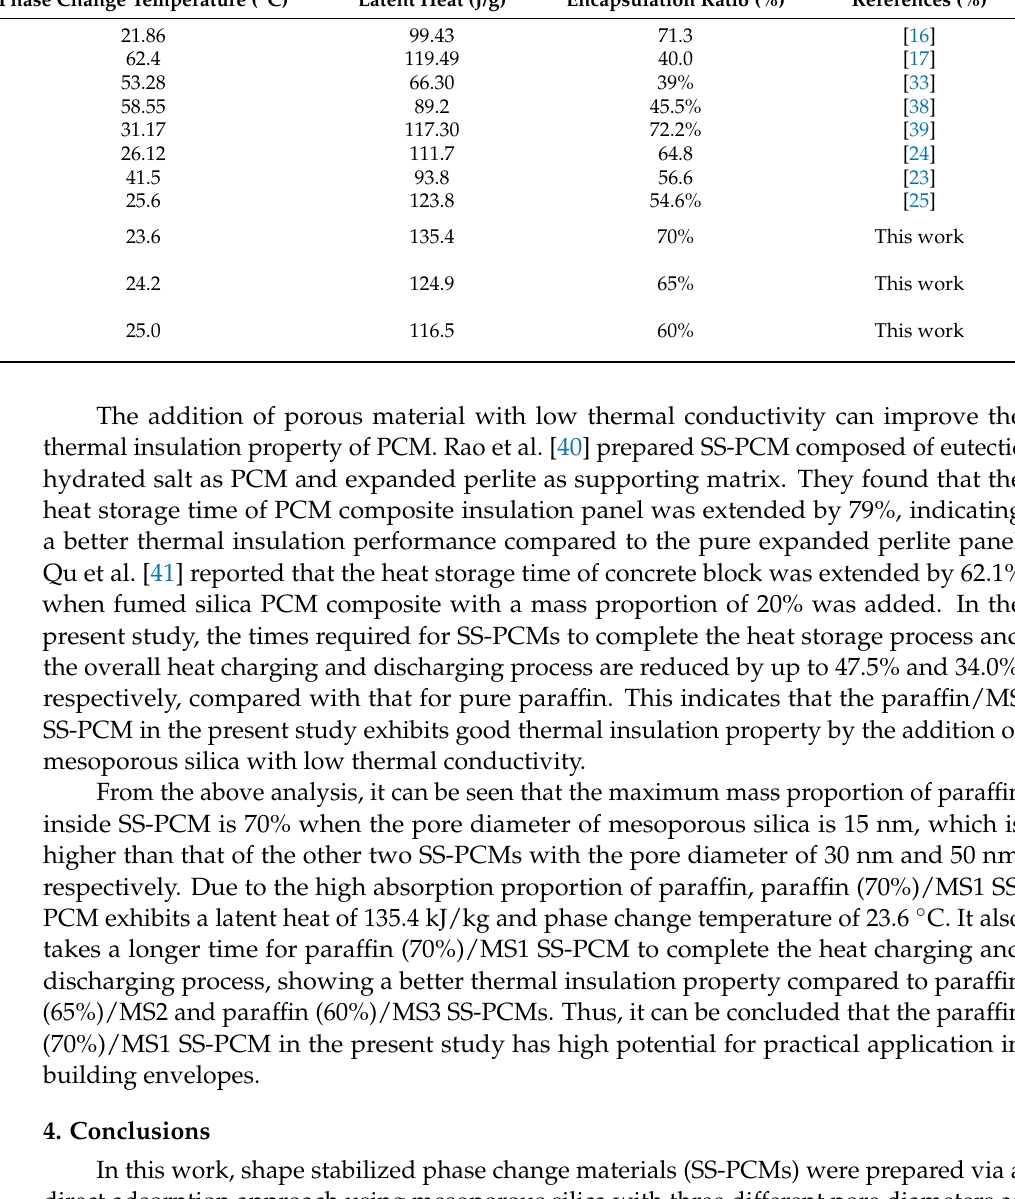
Table 4. Comparison of thermophysical properties of paraffin/MS SS-PCMs with those of some SS-PCMs in literature. SS-PCMs Phase Change Temperature ( ◦ C) Latent Heat (J/g) Encapsulation Ratio (%) References